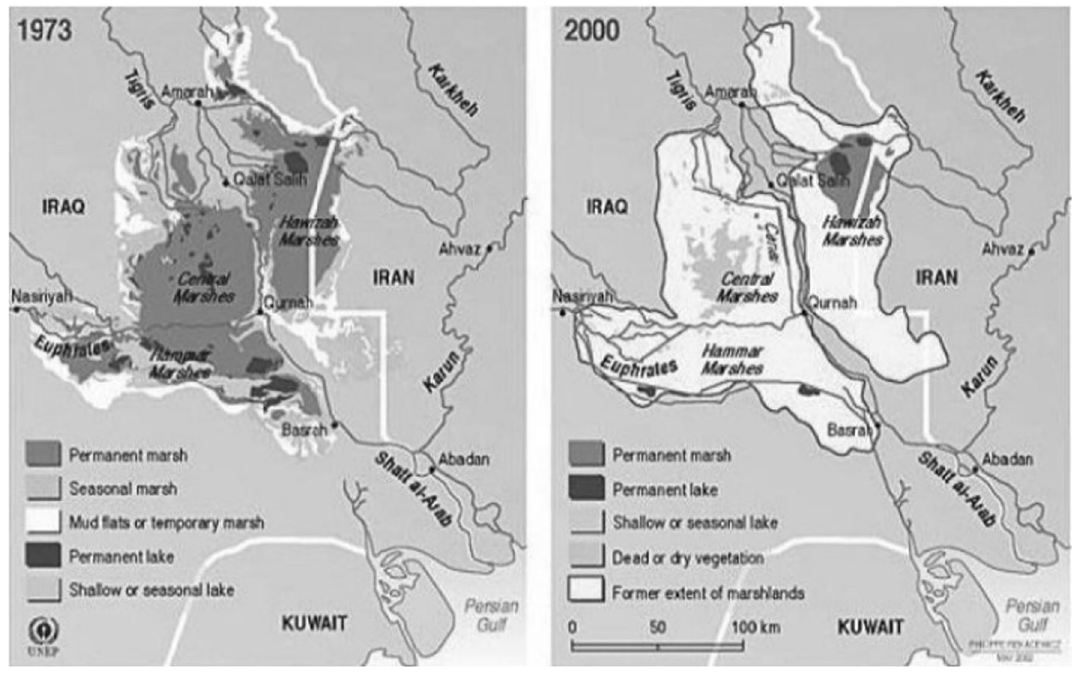
Fig. 10 Difference in the terrestrial protection of Mesopotamian Wetlands from 1973 to 2000 (Mirzaei